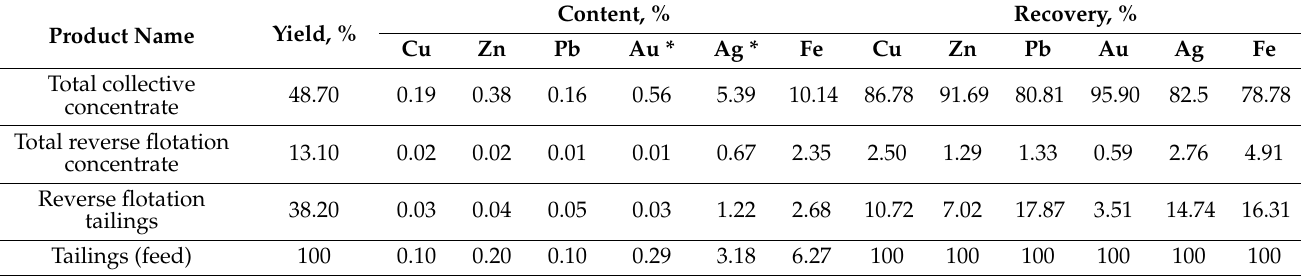
Table 8. Technological balance of metals for old tailings